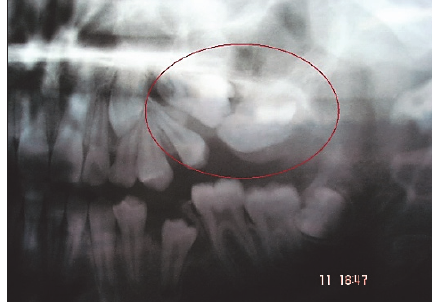
Figure 3: Cystic lumen lined by para- to orthokeratinised stratified squamous epithelium projecting into the lumen in the form of finger-like projections and filled with keratin. Capsule exhibiting dense inflammation (arrow) (4x, H&E).